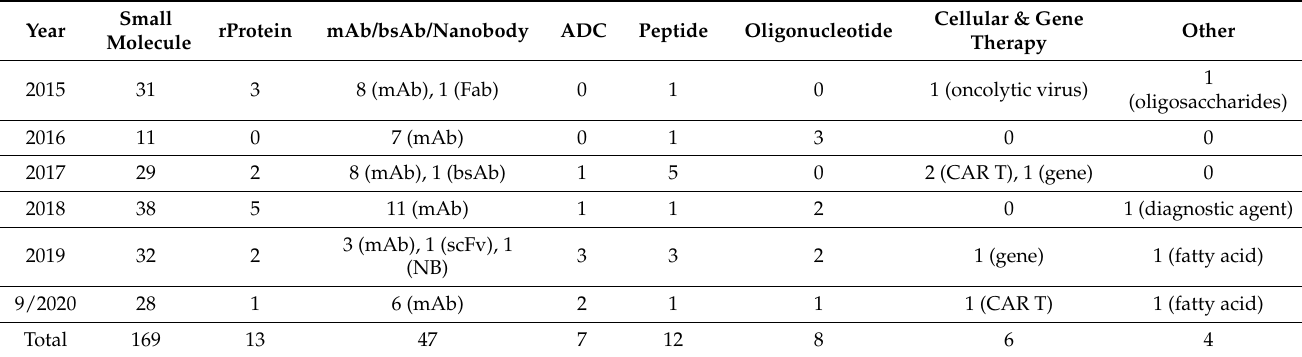
Table 3. Novel therapeutic modalities approved in